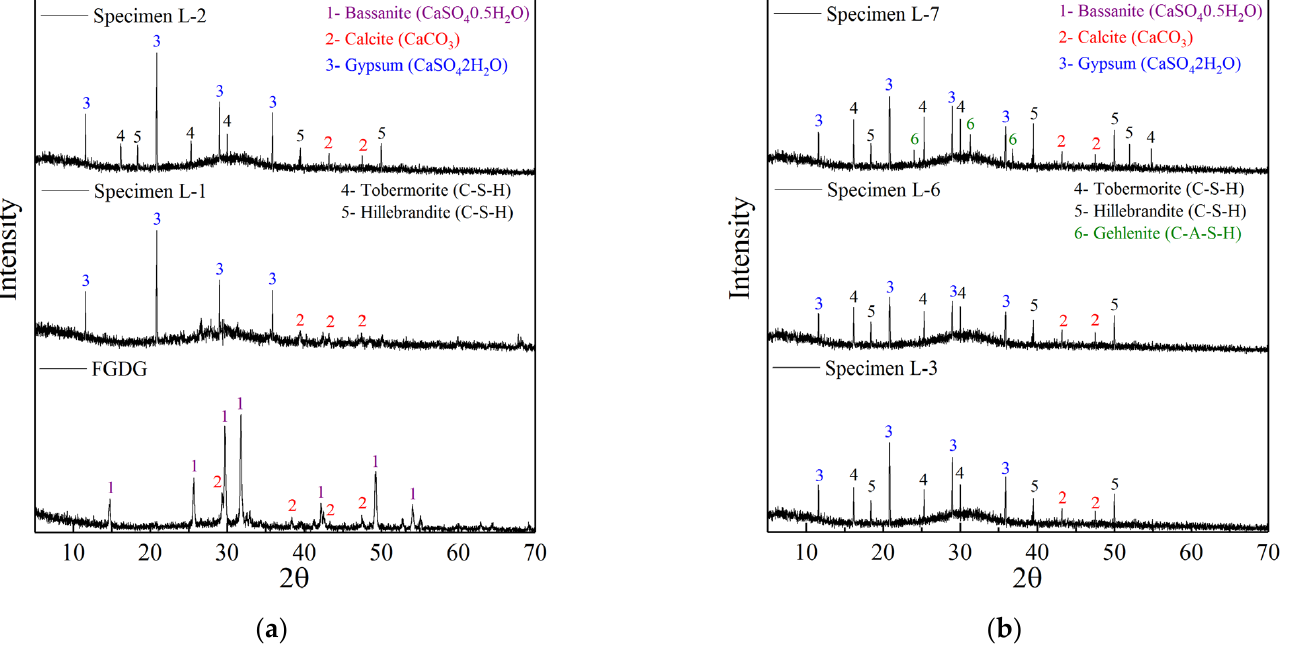
Figure 3. XRD analysis. ( a ) Specimens L-1 to L-2. ( b ) Specimens L-3 to